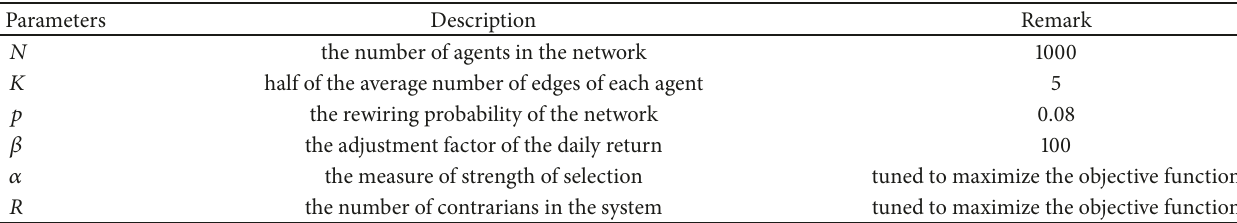
Table 2: Description of parameters.